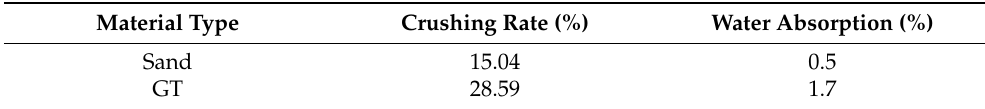
Table 3. The crushing rate and water absorption rate of sand and